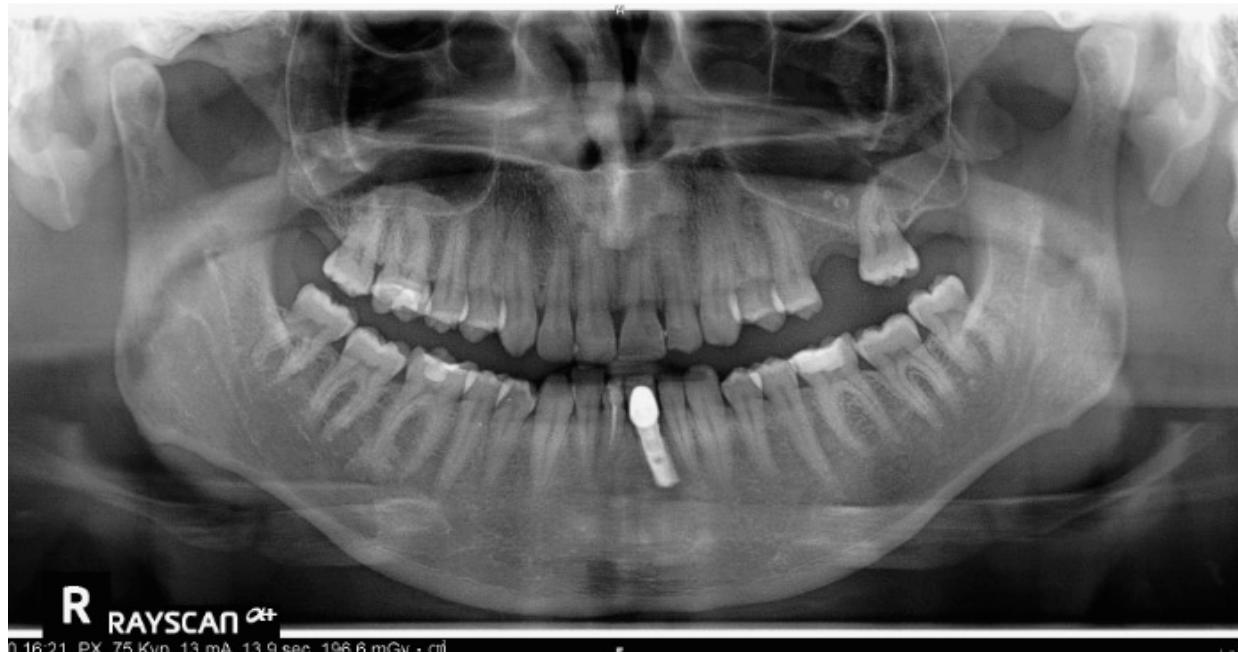
Figure 26. Absence of element 26, implant-prosthesis of element 31, and condylar asymmetry. It was indicated to investigate the diagnostic with an X-ray of elements 36 and 46.